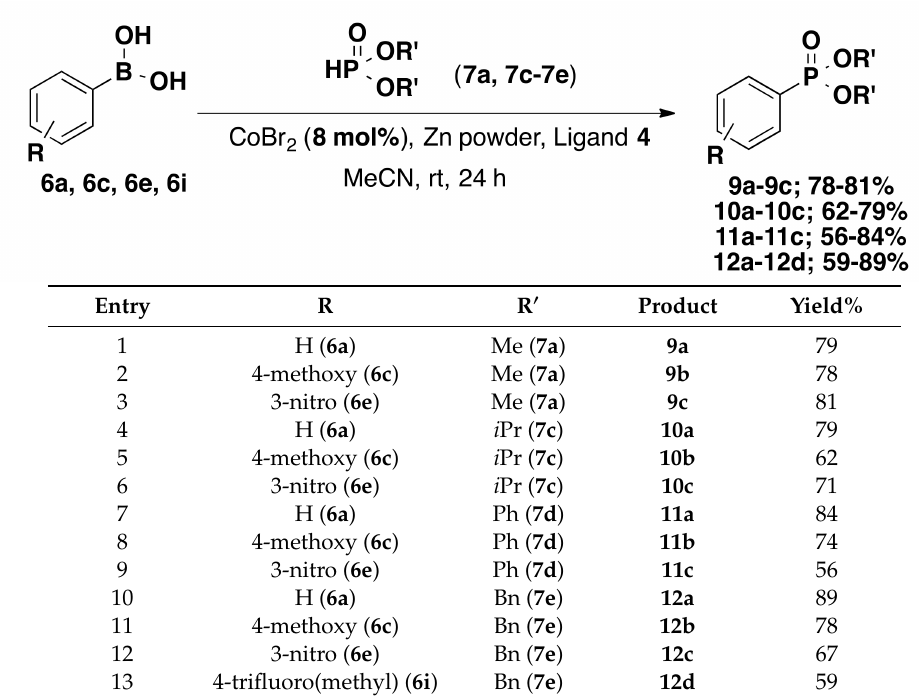
Table 4. Results of screening di ff erent dialkyl / diaryl phosphites a